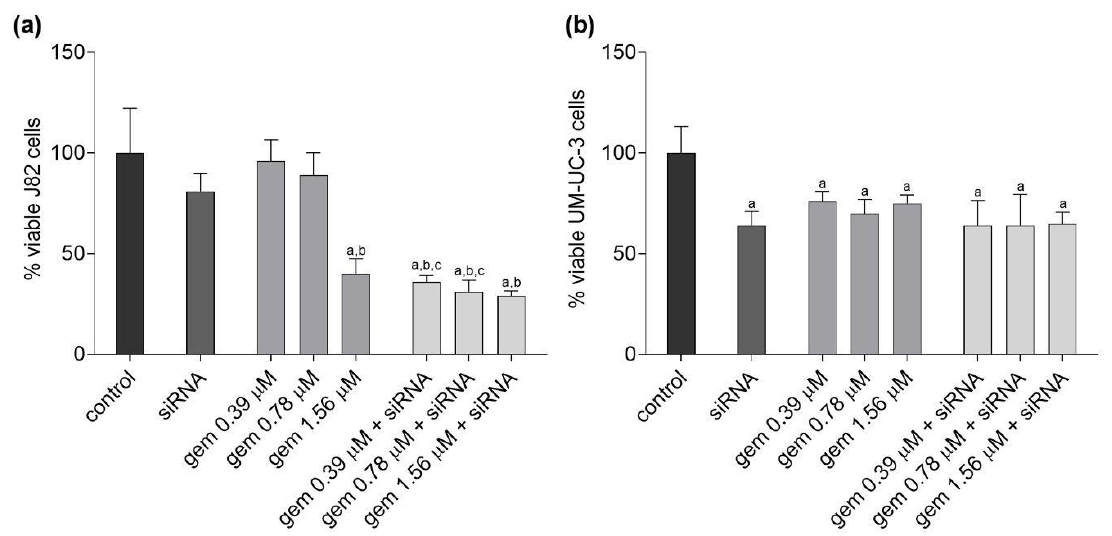
Figure 2. Percentage of viability in J82 ( a ) and UM-UC-3 ( b ) cell lines after treatment with gemcita- bine, siRNA- JHDM1D-AS1 , or gemcitabine combined with siRNA- JHDM1D-AS1 . Control: un- treated cells; gem: gemcitabine. a: p < 0.05 compared to control; b: p < 0.05 compared to siRNA; c: p < 0.05 compared to respective gemcitabine concentration alone.